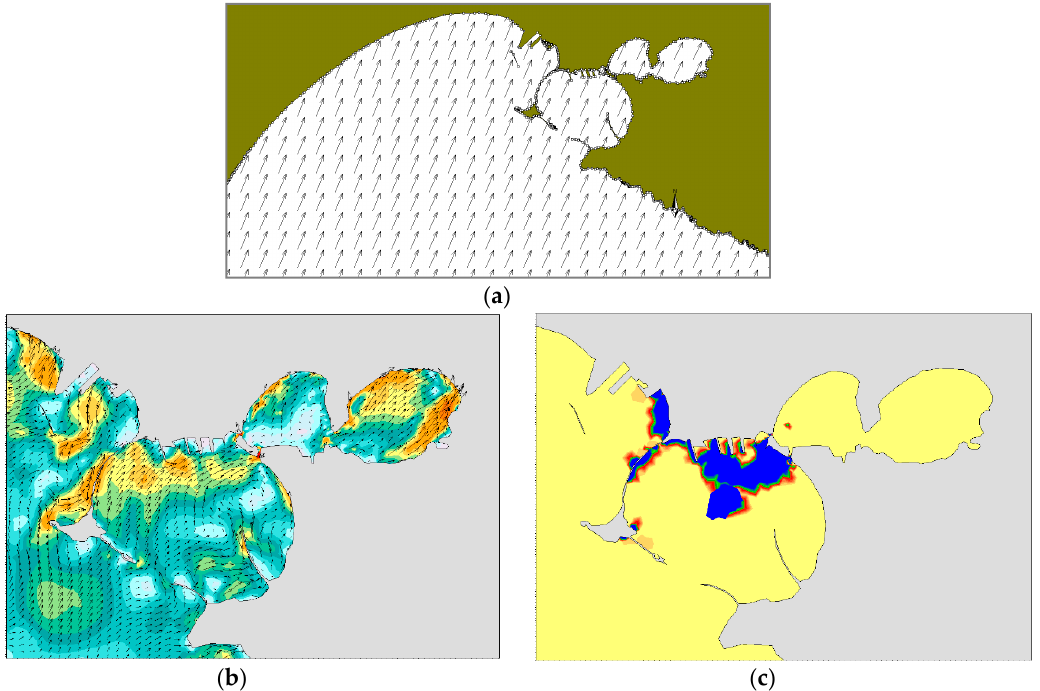
Figure 13. Test T2. July 13, at 12:00. ( a ) Model wind fields ( b ) Surface currents; ( c ) Oil slicks. Legends as in Figure 9.